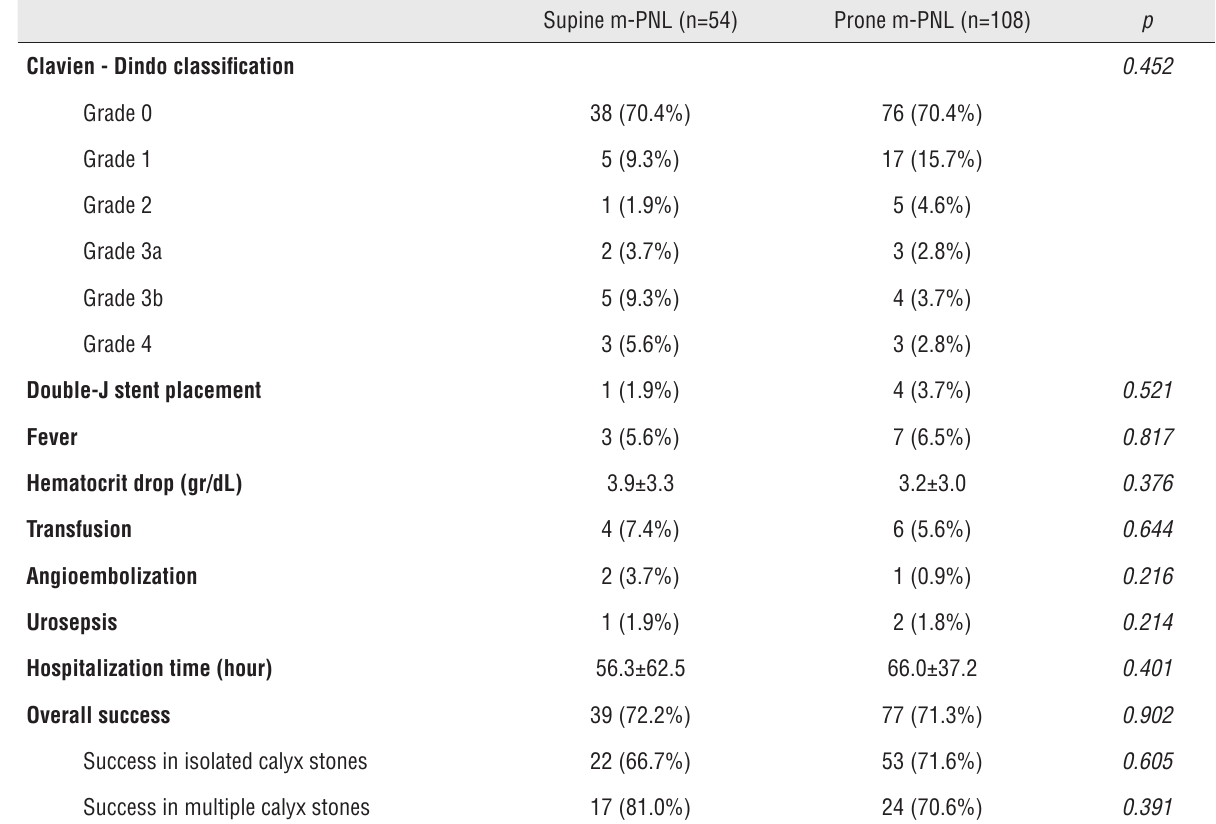
Table 3 - Postoperative complications and